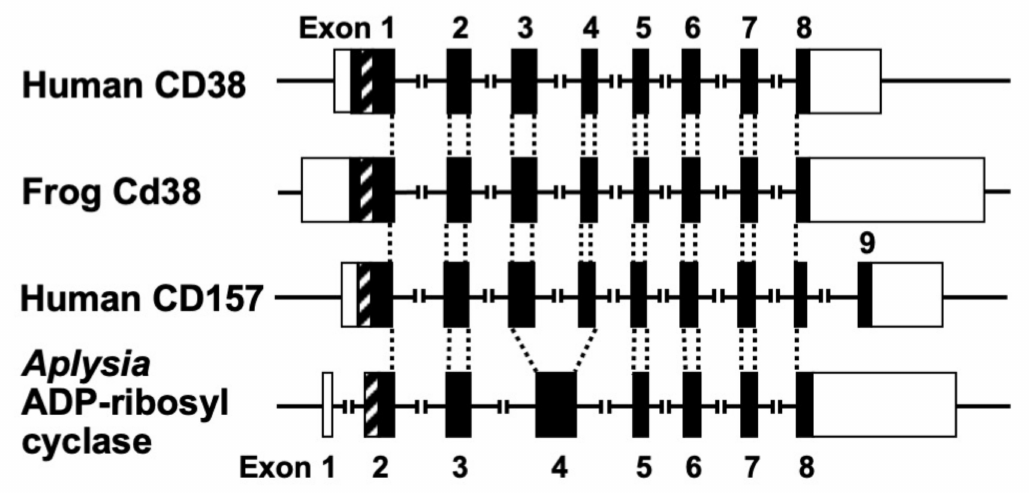
Figure 3. Structural organization of human CD38, frog Cd38, human CD157, and Aplysia kurodai ADP- ribosyl cyclase genes (adapted from [9,27,44]). The exons are depicted as boxes; filled and open boxes represent protein-coding regions and untranslated regions, respectively. Recently, primate-specific exon 1b, located between exon 1 and 2 of human CD157, that encodes 15 additional amino acids, was reported [48]. Hatched boxes represent transmembrane (CD38)- or signal peptide (CD157 and Aplysia ADP-ribosyl cyclase)-coding regions. The corresponding exon-intron junctions are indicated as broken lines. Exons are